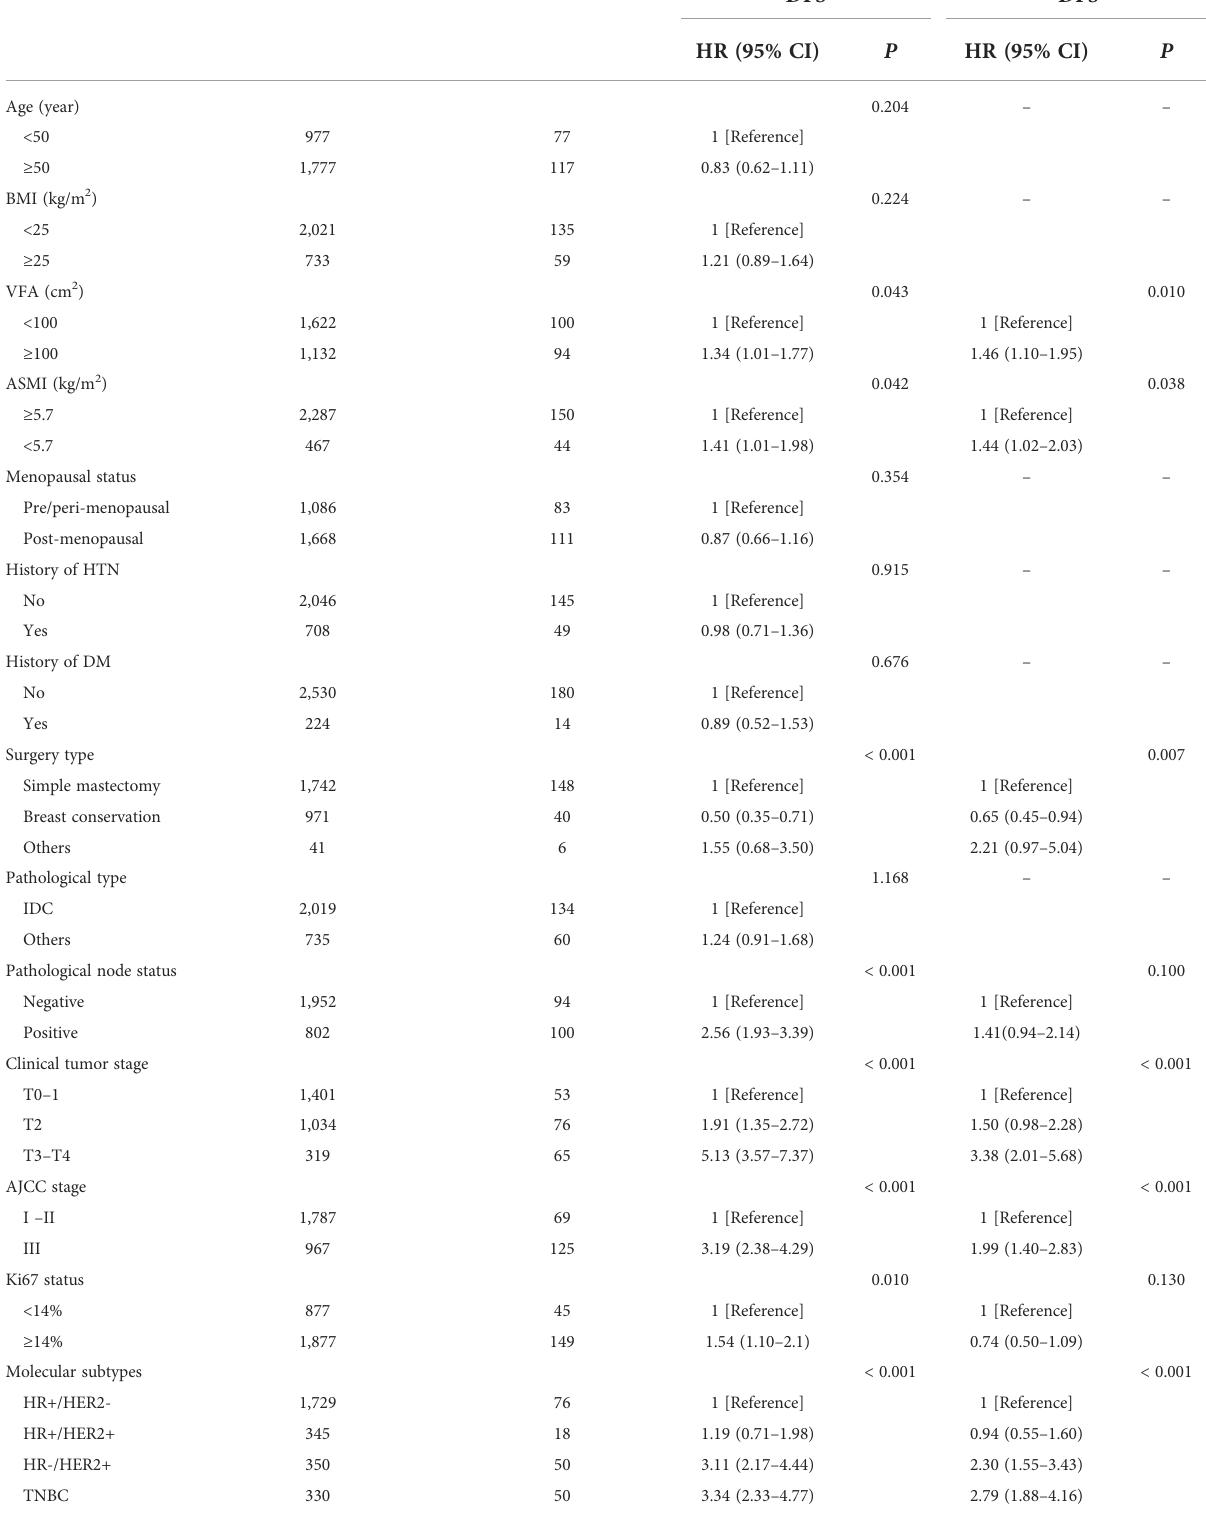
TABLE 2 Univariate and multivariate analysis of factors associated with disease-free survival